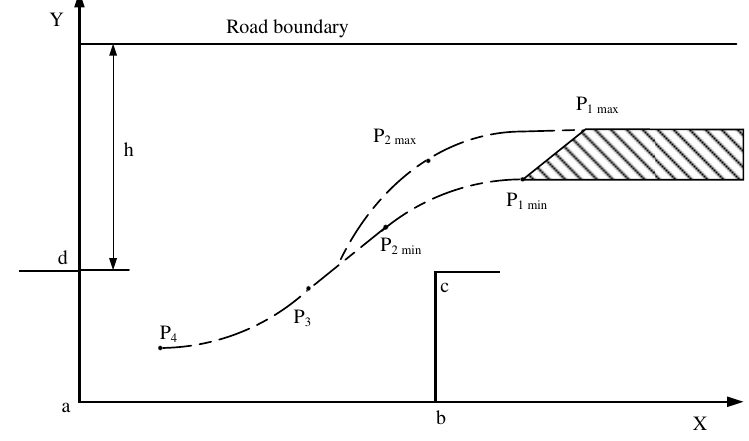
Figure 4. Parking starting point area.